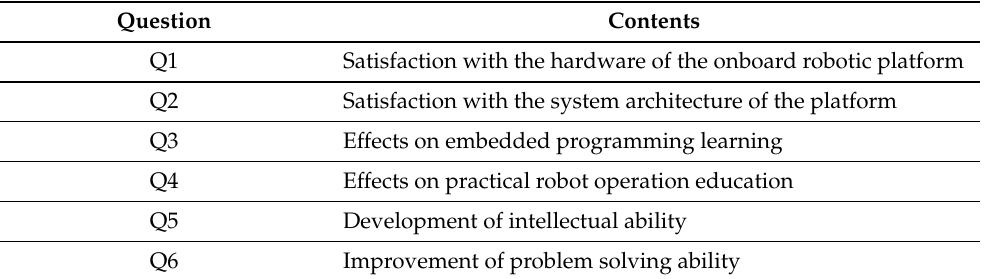
Table 3. List of questions in the questionnaire.